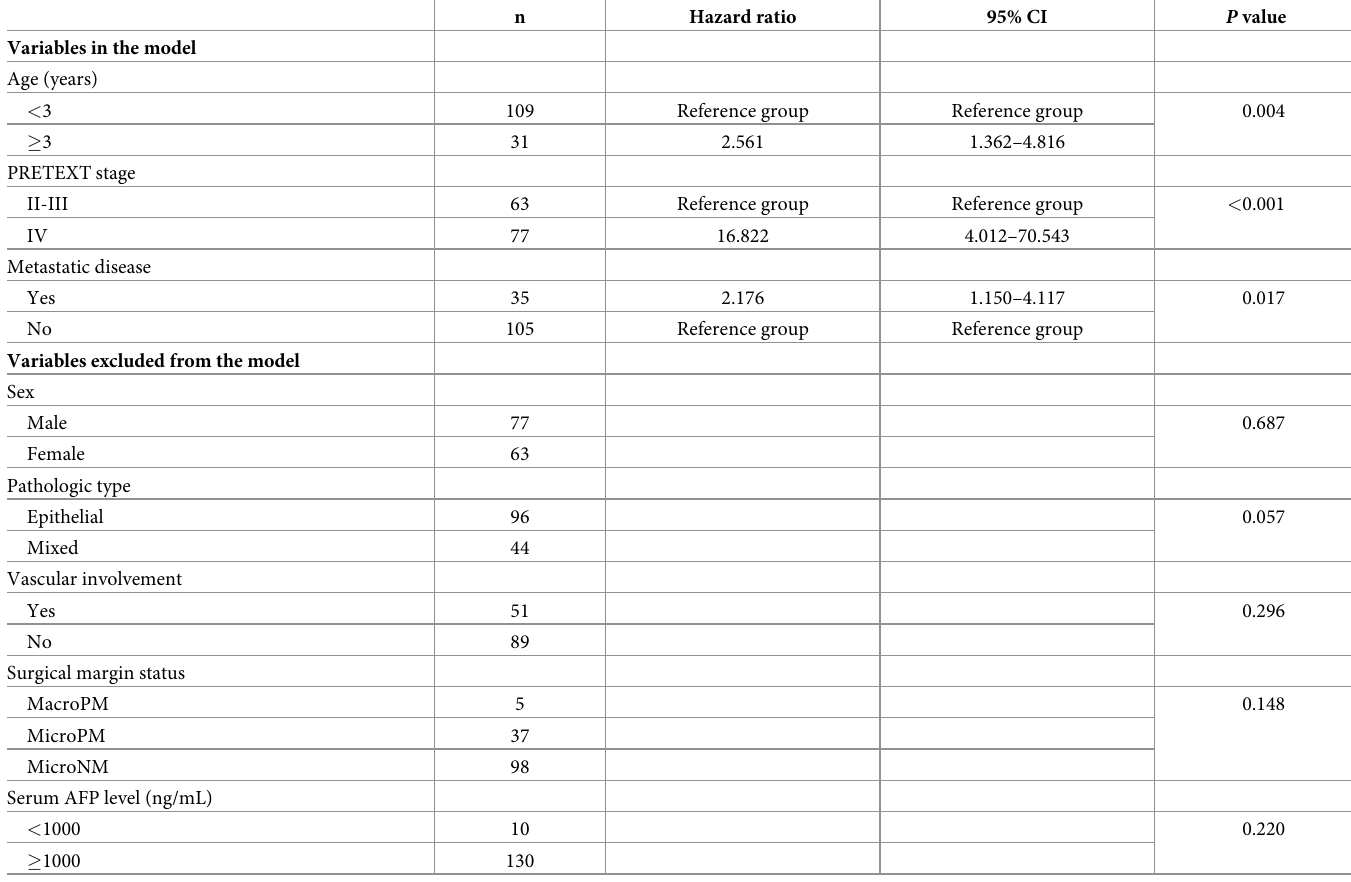
Table 4. Cox proportional hazard model for the independent risk factors of recurrence in 140 children with initial CR.